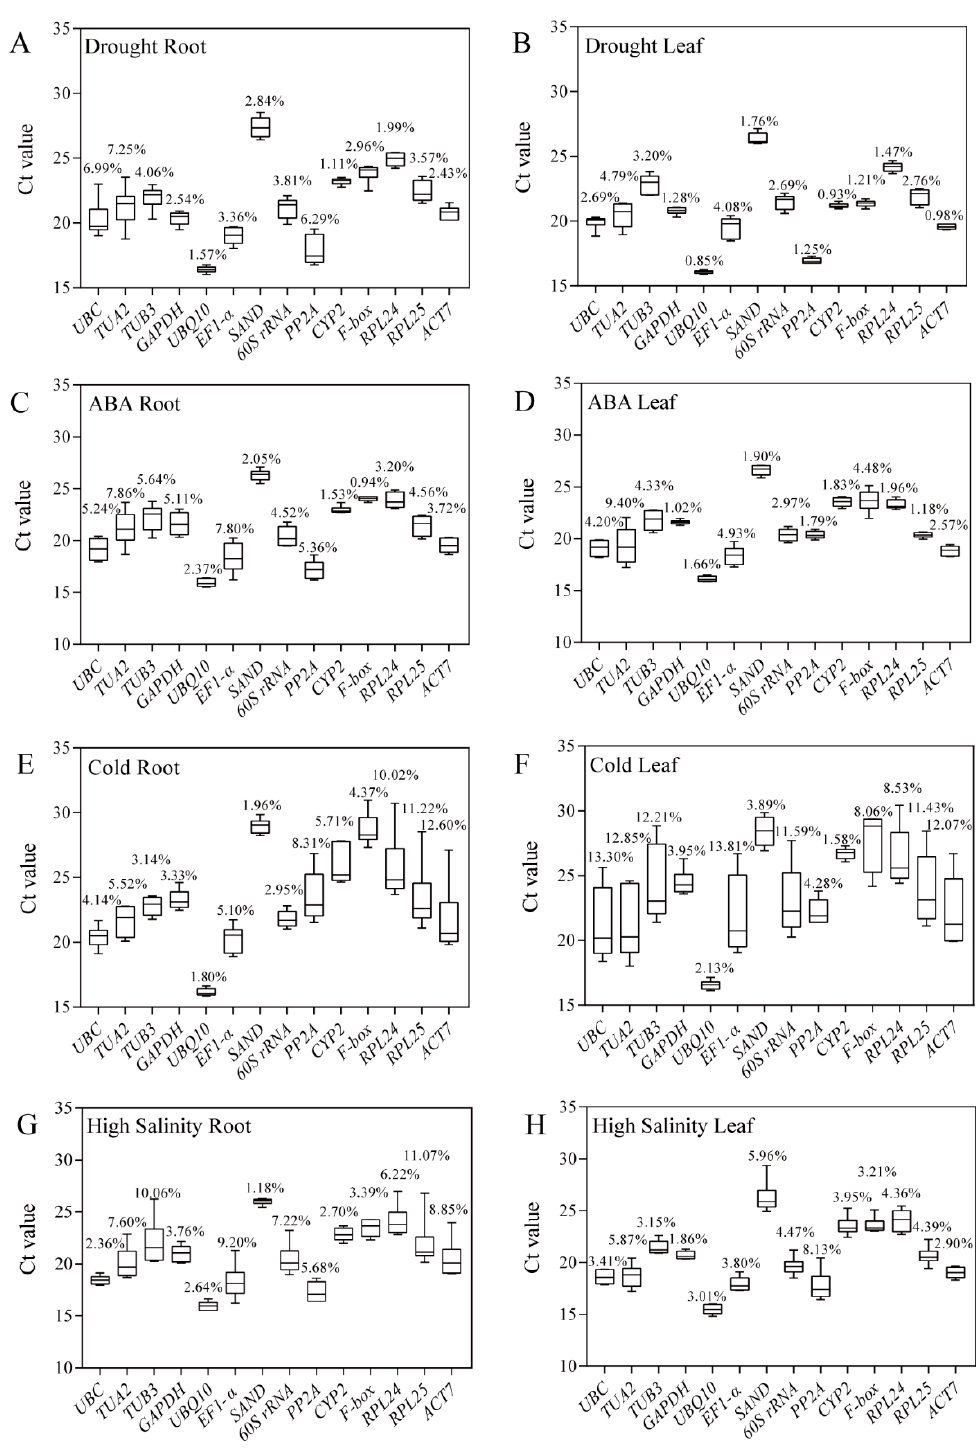
Figure 1. Threshold cycle (Ct) values of fourteen candidate reference genes in roots and leaves under various stresses and ABA treatment. Boxplot of Ct values of fourteen candidate reference genes from qRT-PCR analysis of root and leaf tissues. ( A , B ) Drought stress; ( C , D ) ABA treatment; ( E , F ) cold stress; and ( G , H ) high salinity stress. For each reference gene, the line inside the box is the median. The top and bottom lines of the box are the first and third quartiles, respectively. The values on top of box represent the coefficient of variation (CV) values.